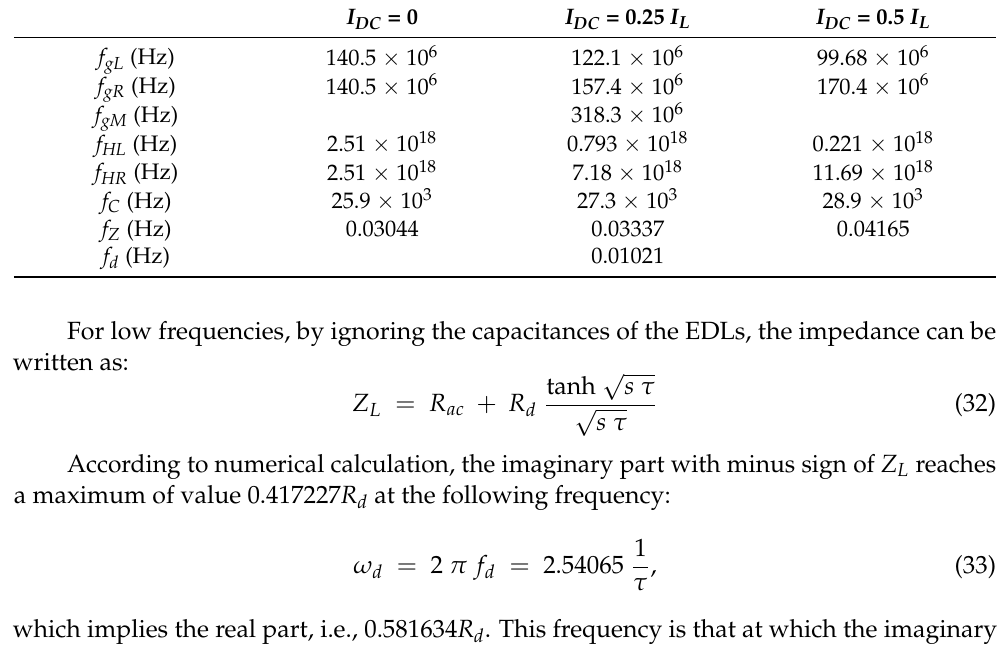
Table 2. Numerical values of the main characteristic frequencies in an ion-exchange membrane system. I DC = 0 I DC = 0.25 I